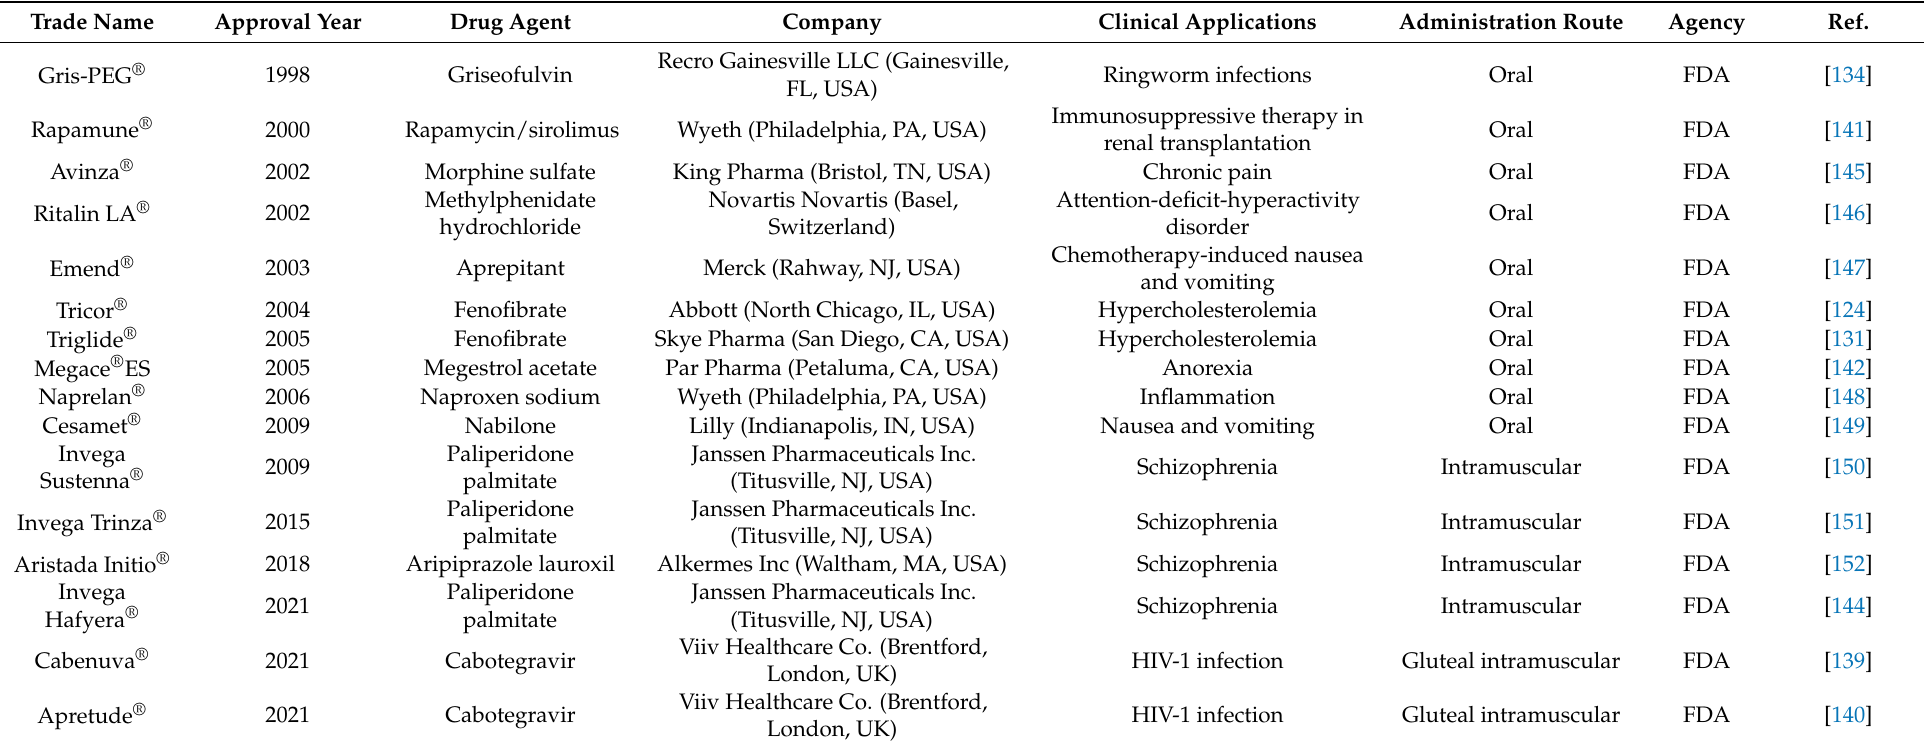
Table 2. Approved NC-based